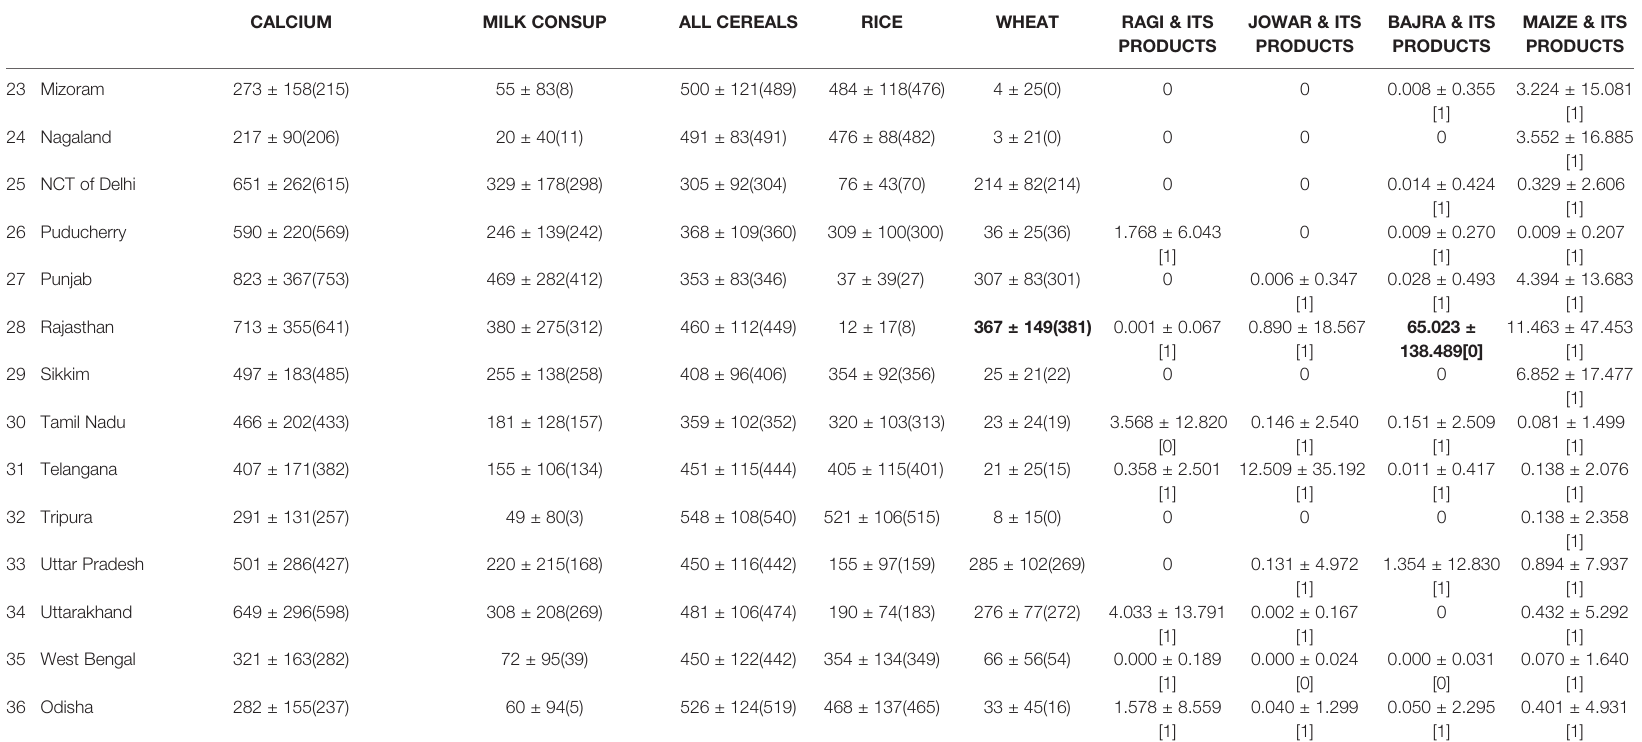
Bold values indicate- highest daily intake of various food categories in different